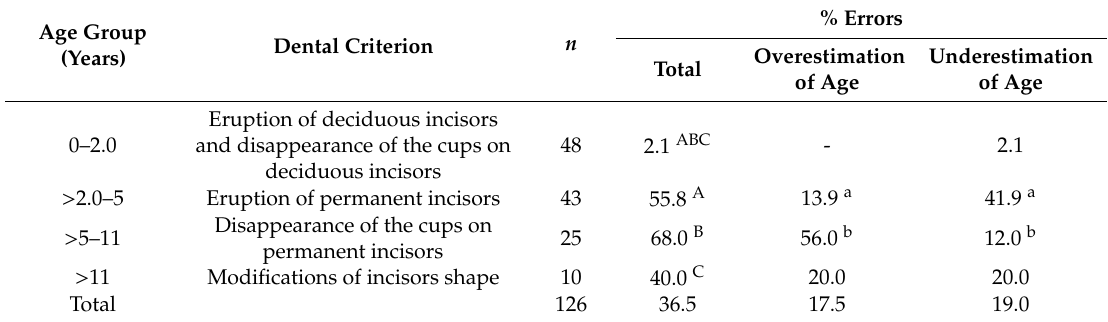
Table 2. Percentage of errors in age assessment based on selected traits of incisors in comparison to the actual age of Icelandic